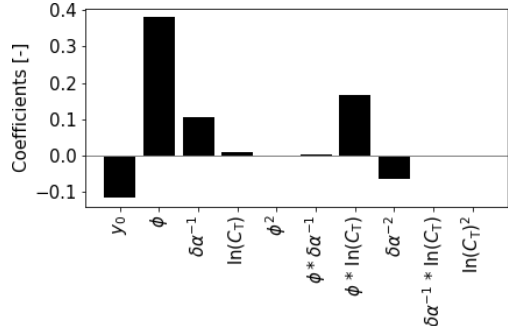
Figure 12. Regression coefficients of DART-3 estimating µ y at x = 6D using scaled input parameters. Since all input parameters are dimensionless, the corresponding coefficients are also dimen- sionless. Variable y 0 indicates the intercept or systematic offset.